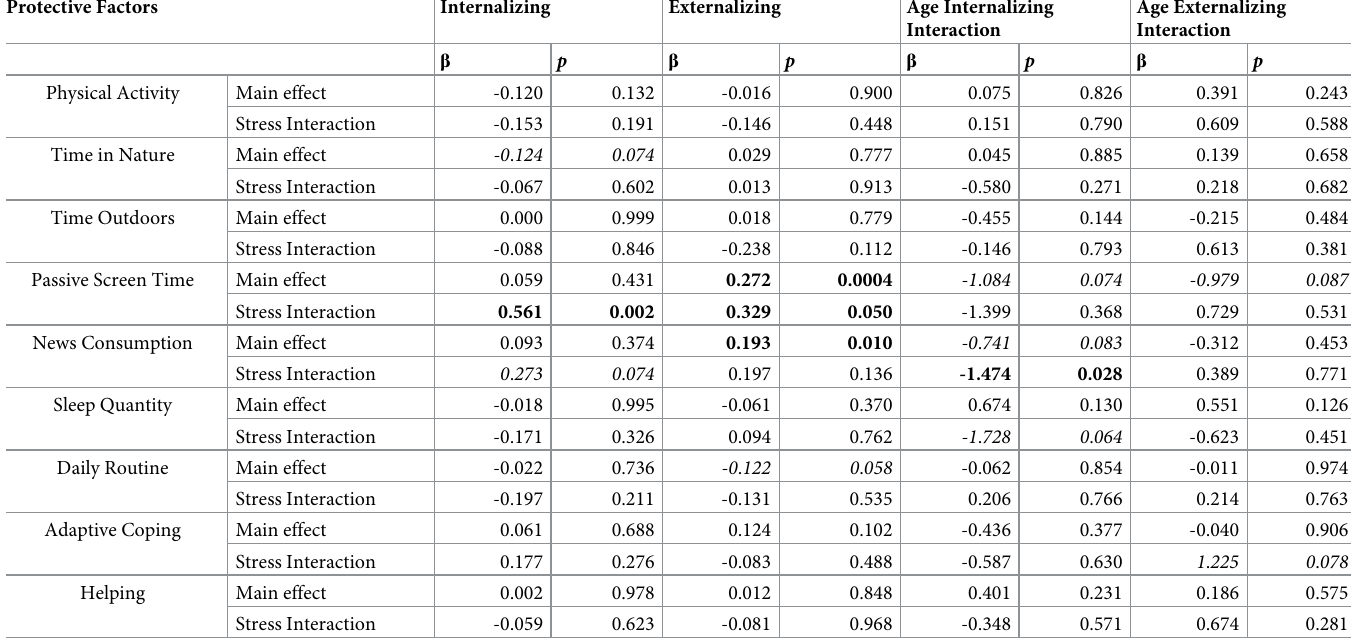
Table 2. Associations of potential protective factors with psychopathology and interactions with stress and age at T1. Significant associations are presented in BOLD and marginal associations are presented in italics.